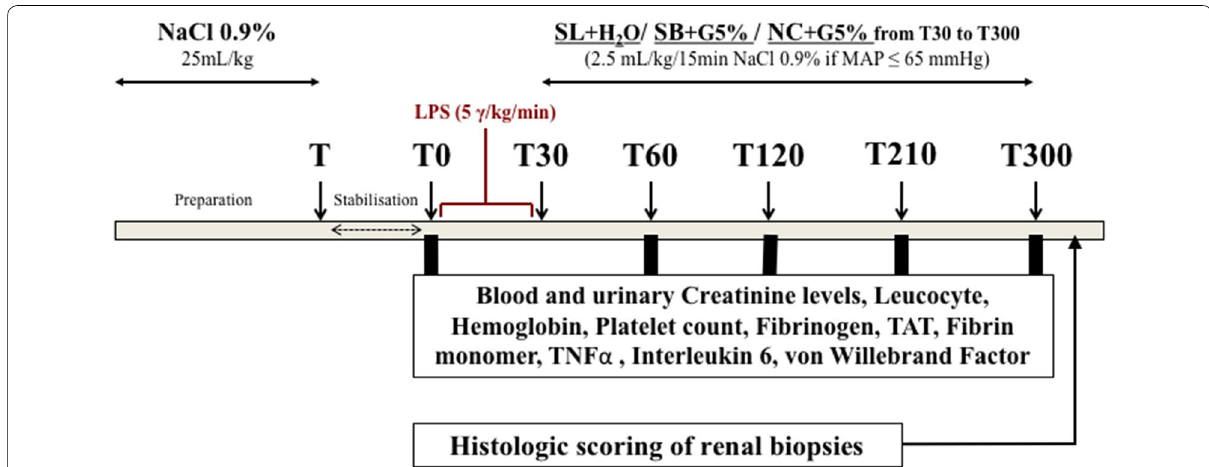
Fig. 1 Study design. During preparation period, all animals received 25 mL/kg 0.9% NaCl to prevent hypovolemia. Measurements were taken over a 5‑h period: at baseline (T0) and at 60 (T60), 120 (T120), 210 (T210) and 300 (T300) minutes. All animals were administered 5 μg/kg/min Escherichia coli lipopolysaccharide (LPS). The endotoxin was infused over a 30‑min period intravenously. The SL group received 40.5 g lactate (3.61 kcal/g). NC and SB groups received an equivalent energy supply: 39 g glucose (3.75 kcal/g) as 780 mL 5% glucose solution from T30 to T300. To ensure the same fluid intake, the SL group received 780 mL sterile water for injection. If mean arterial pressure (MAP) felt below 65 mmHg, 2.5 mL/kg infusion of NaCl 0.9% was given as rescue therapy every 15 min. At the end of the study period, all animals were sacrificed with T61 administration.